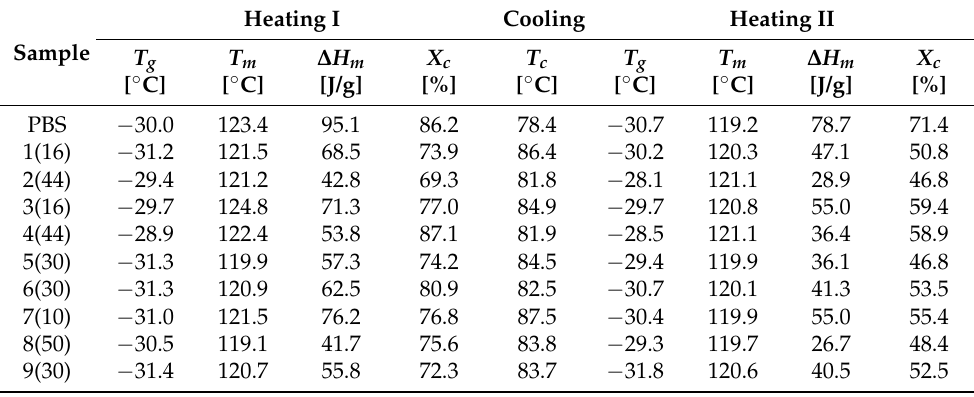
Table 6. Melting point T m , crystallization T c and glass transition T g temperatures, the enthalpy of melting ∆ H m and degree of crystallinity X c of PBS and its composites with bran, based on differential scanning calorimetry (DSC)